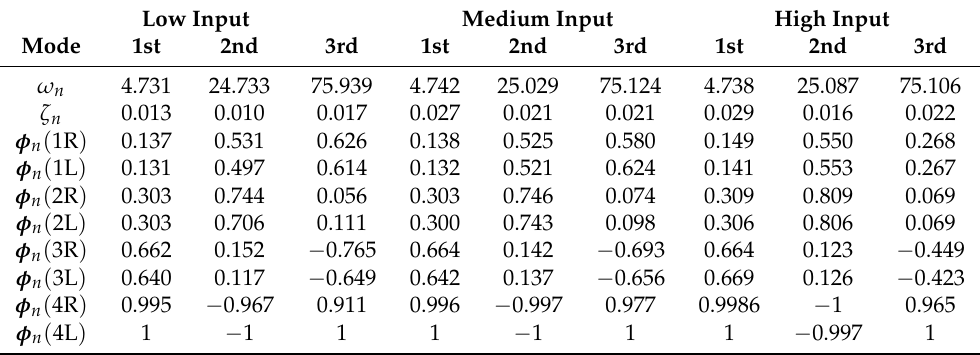
Table A1. Twin spar: identified modal